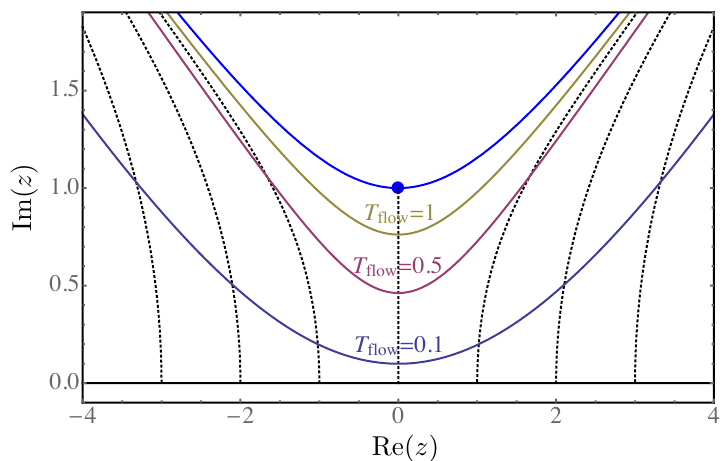
Figure 1 . Complex contours J (cid:3)= 1 ( T (cid:13)ow ) for the Airy integral with the trivial metric. The dashed black curves show (cid:13)ow lines with initial condition at the intersection with the real